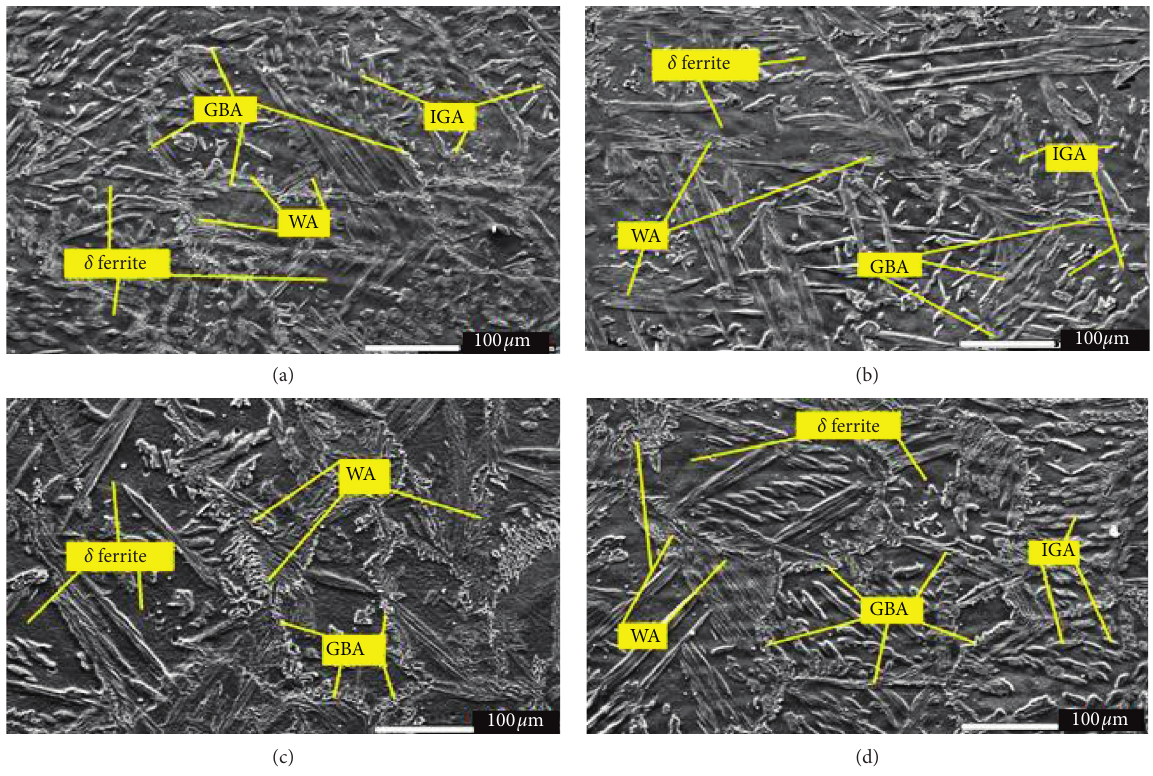
Figure 6: Micrographs in the fusion zone of DSS 2205 in TIG and (a) TIG, (b) ATIG 1, (c) ATIG 2, and (d) ATIG 3 ( × 200). (a) TIG weld zone (200 × ). (b) ATIG 1 weld zone (200 × ). (c) ATIG 2 weld zone (200 × ). (d) ATIG 3 weld zone (200 ×